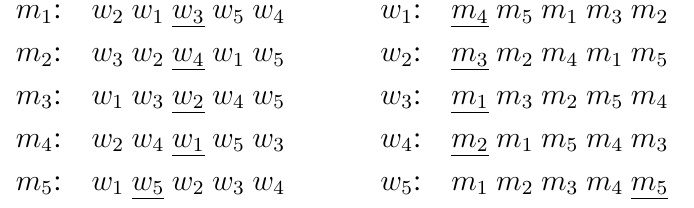
Figure 3. A counter example for the naive algorithm where k = 2 . Man-optimal partners are underlined. An optimal solution is obtained by moving w m ’s preference lists respectively, as a result of which the score decreases by seven. Any 5 choice of two men and moving their man-optimal partners to the top decreases the score by at most